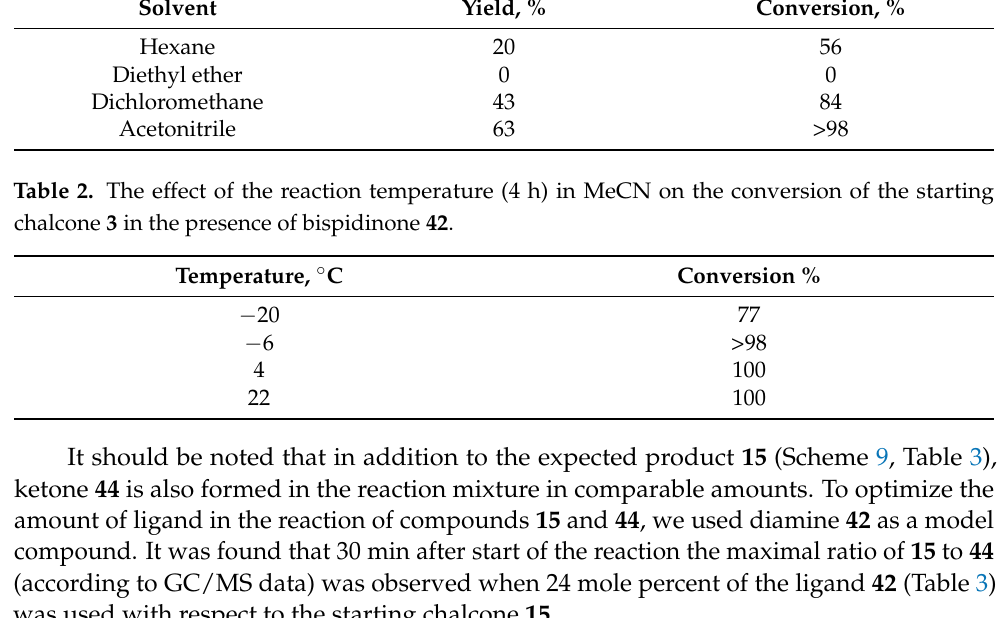
Table 1. The effect of the solvent on the yield of 15 in the presence of bispidinone 42 at − 6 ◦ C for 4 h. Solvent Yield, % Conversion, % Hexane